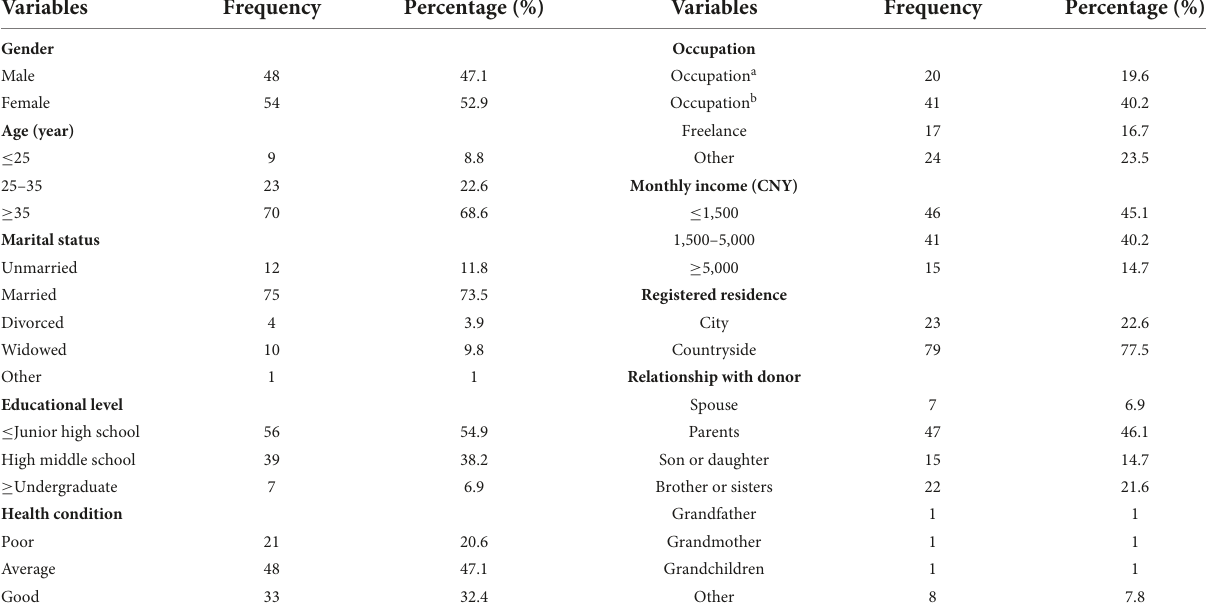
TABLE 1 General demographic data of respondents ( N = 102).